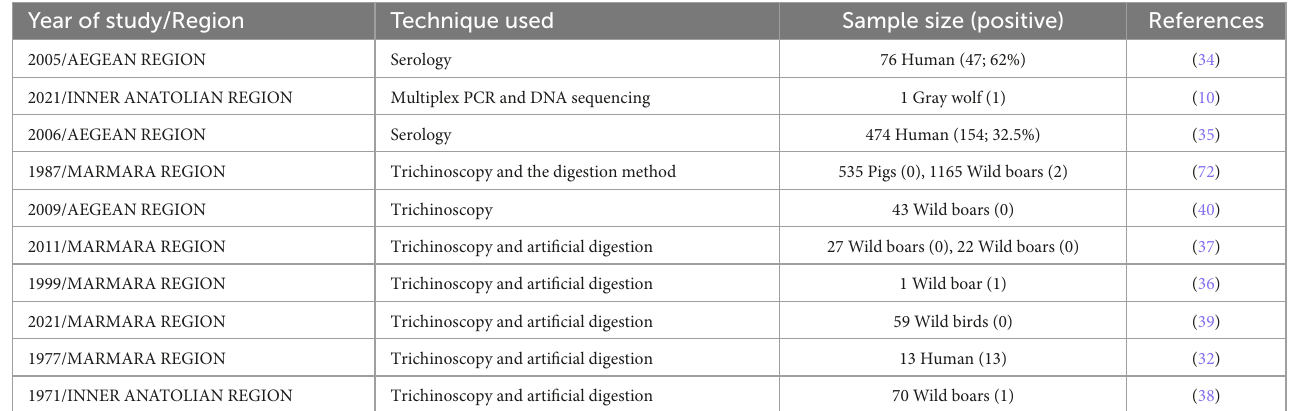
TABLE 2 Investigations on Trichinella sp. in human and animals of